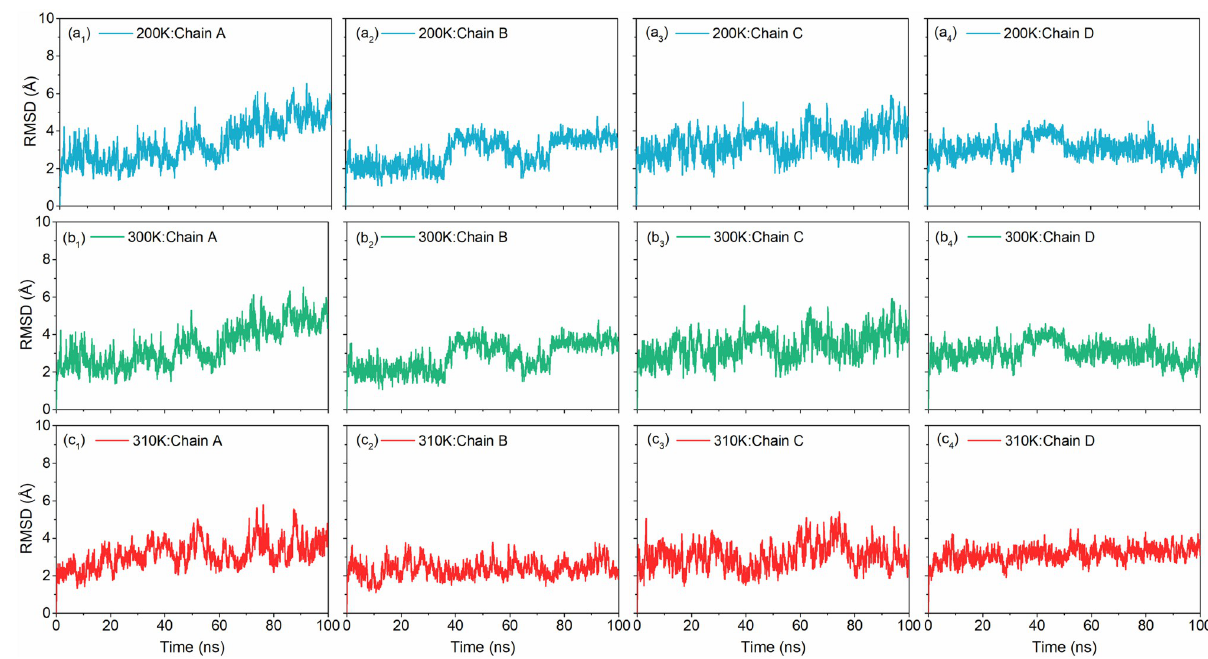
Fig 2. RMSD plots of the MD simulations of the DNA junction at (a) 200K, (b) 300K and (c) 310K.